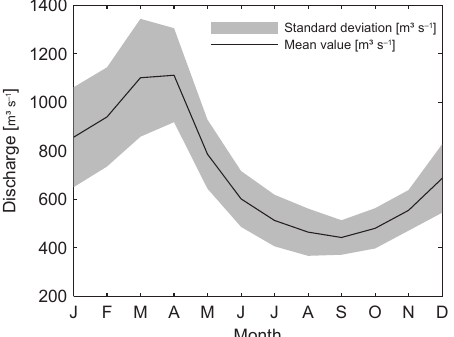
Figure 3. Seasonal cycle of monthly mean discharge data (black line) with corresponding standard deviation of gauge Neu Darchau from 1875 to